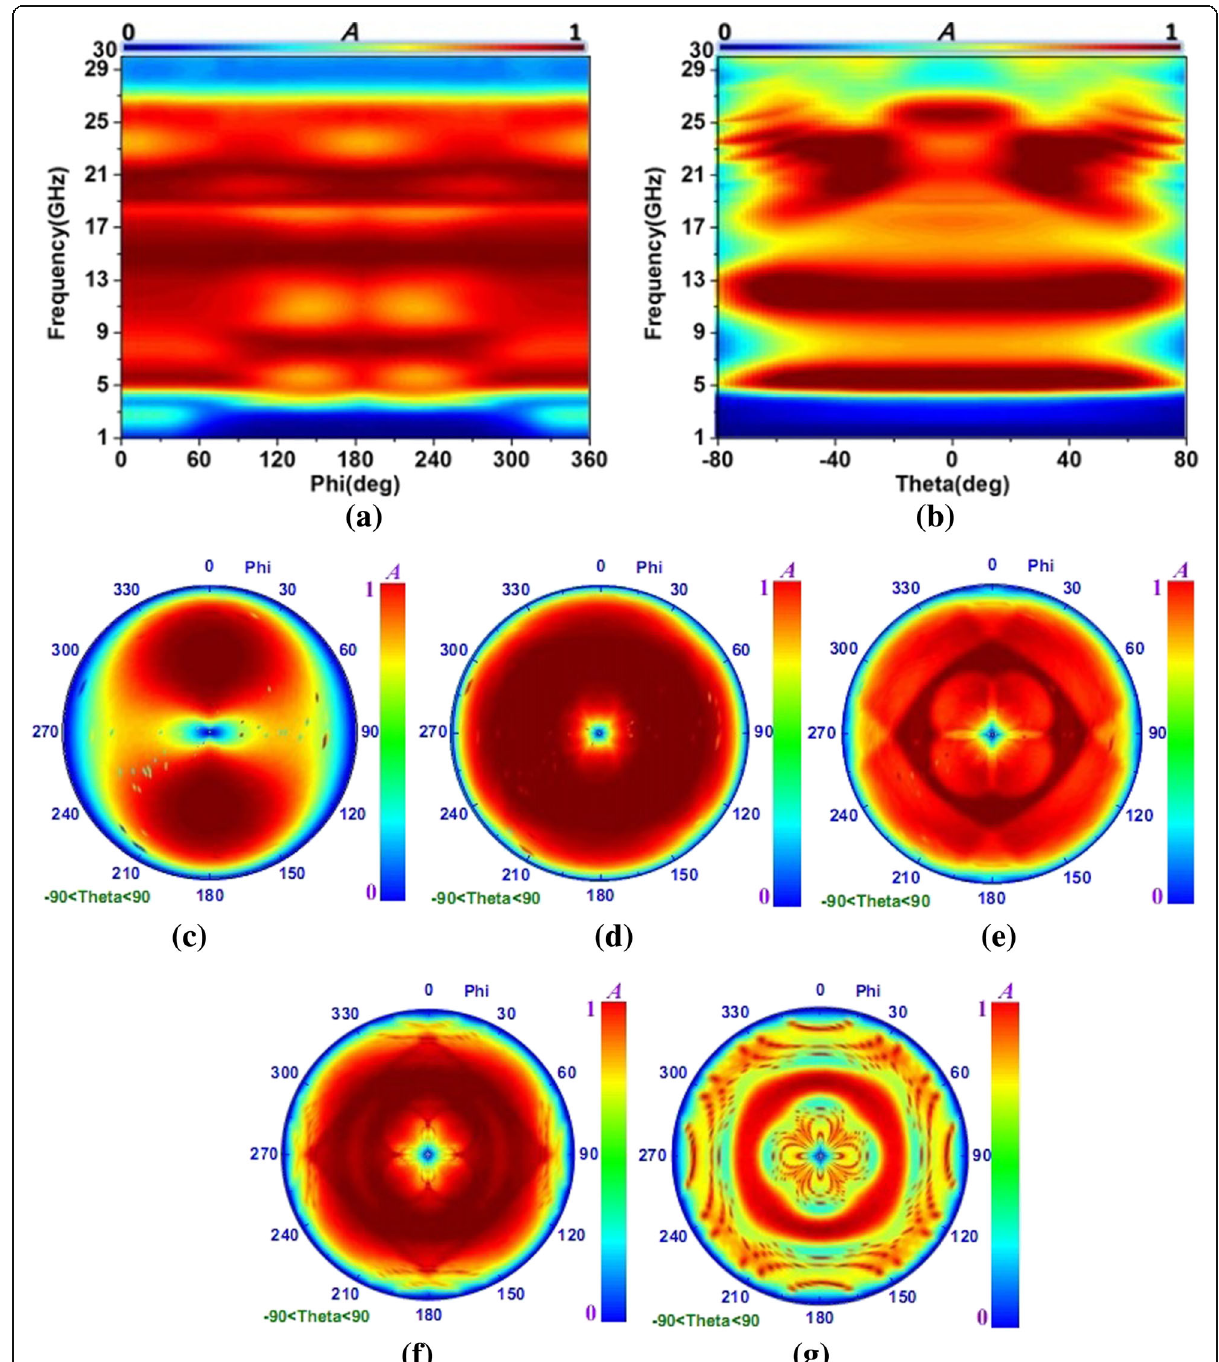
Fig. 5 The absorption results of the present ultra-broadband PMA with different angles of theta and phi. a Absorption results of the PMA with different angles of phi from 1 to 30GHz (theta=0deg). b Absorption results of the PMA with different angles of theta from 1 to 30GHz (phi=0°). c Absorption results at 5.13GHz with − 90°<theta<90° and 0°<phi<360°. d Absorption results at 14.49GHz with − 90°<theta<90° and 0°<phi<360°. e Absorption results at 19.05GHz with − 90°<theta<90° and 0°<phi<360°. f Absorption results at 20.77GHz with − 90°<theta<90° and 0°<phi<360°. g Absorption results at 25.42GHz with − 90°<theta <90° and